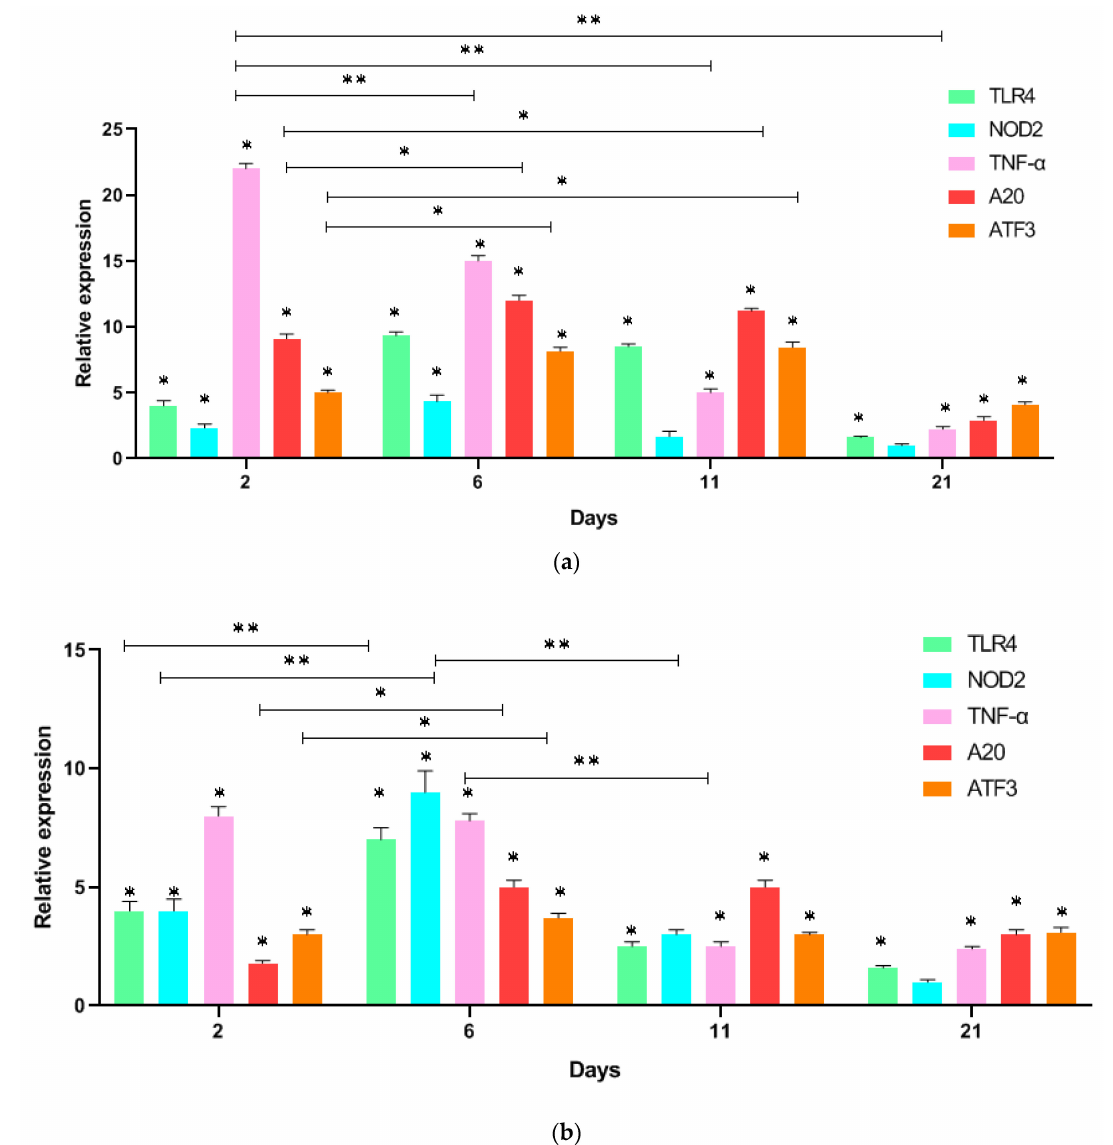
Figure 1. Relative expression of genes TLR4, NOD2, TNF- α , A20, and ATF3 with normalization for expression of GAPDH before i.p. stimulation (day 1) in mononuclear cells of mice on the 2, 6, 11, 21 days; ( a ) ip injection of LPS; ( b ) ip injection of GMDP; relative expression differences of more than 2 times were considered significant; data are represented as an average of three independent samples and error bars represent standard deviation; * p < 0.01; ** p